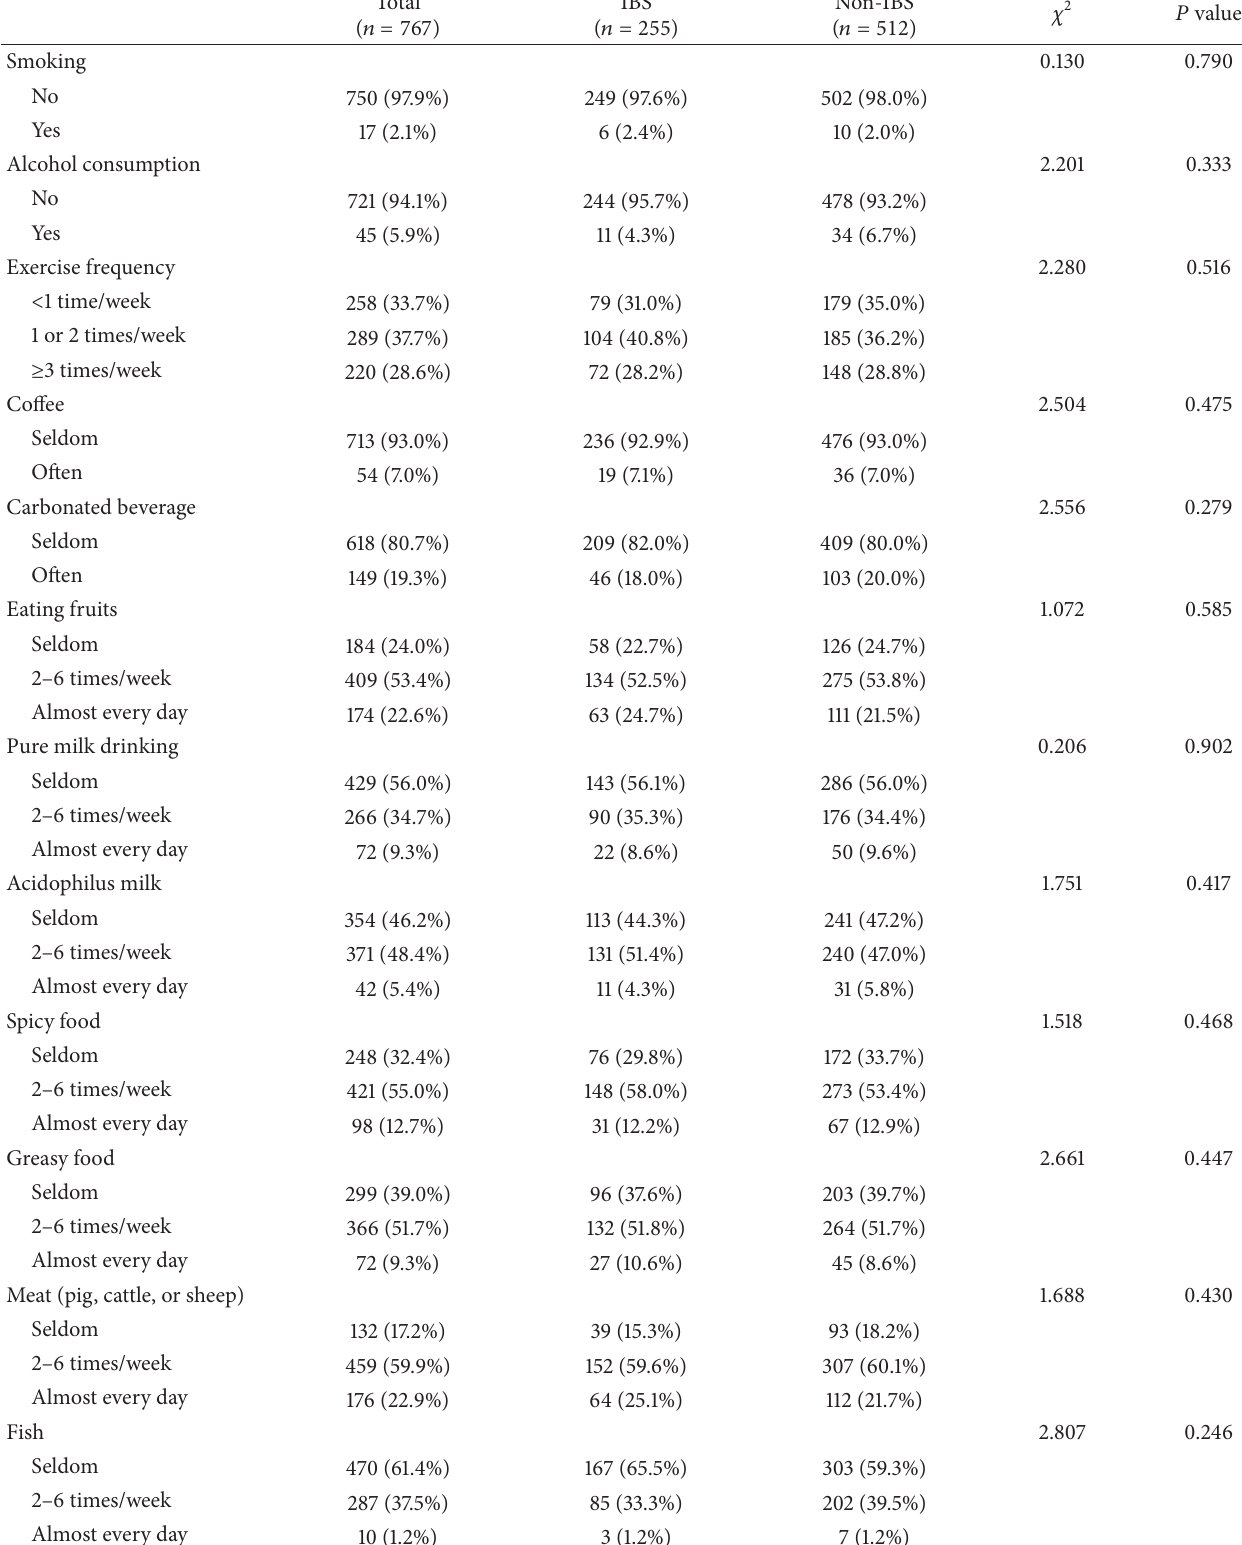
Table 2: Lifestyle and eating habits of medical students with or without IBS n